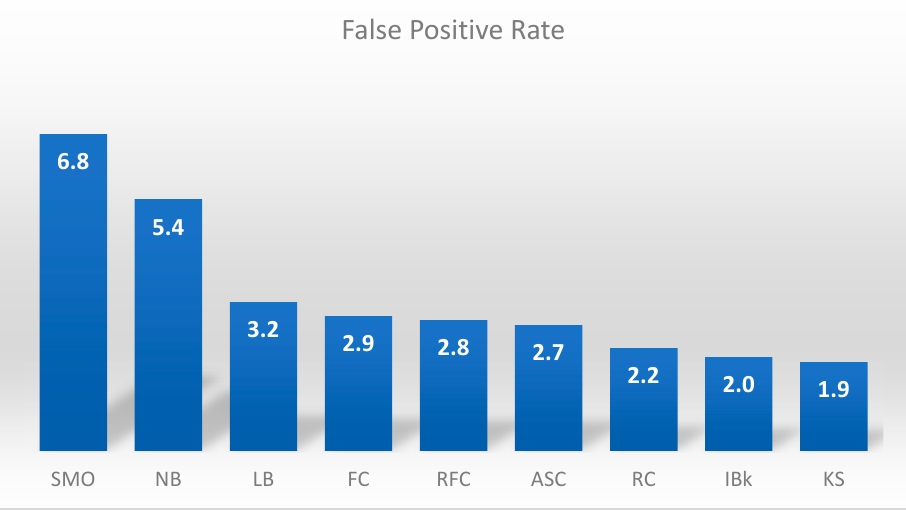
Figure 14. False positive rate.